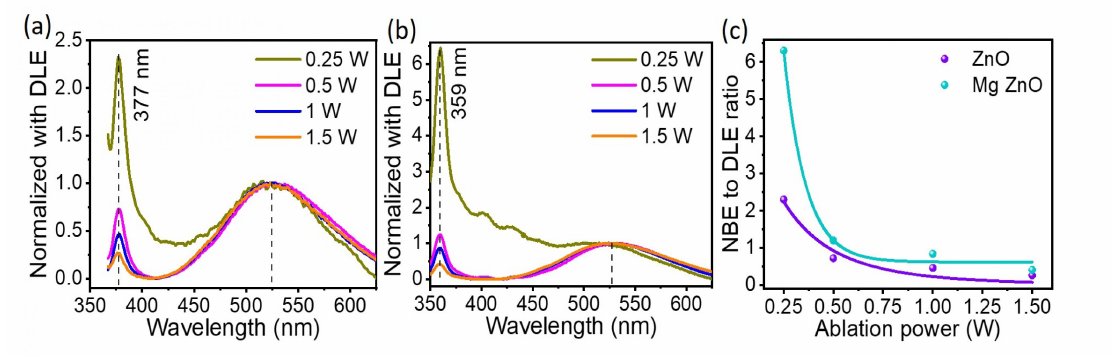
Figure 4. The photoluminescence (PL) for ZnO nanoparticles at room temperature for different ablation powers used in the fs-PLAL process, ( a ) for ZnO and ( b ) Mg-doped ZnO. PL emission from nanoparticles prepared with ablation powers of 0.25 W, 0.5 W, 1 W and 1.5 W are depicted in differently colored curves as indicated in the legend. ( c ) The ratio of the amplitudes of the NBE to DLE emission from fs-PLAL nanoparticles prepared and different average powers of the ablating